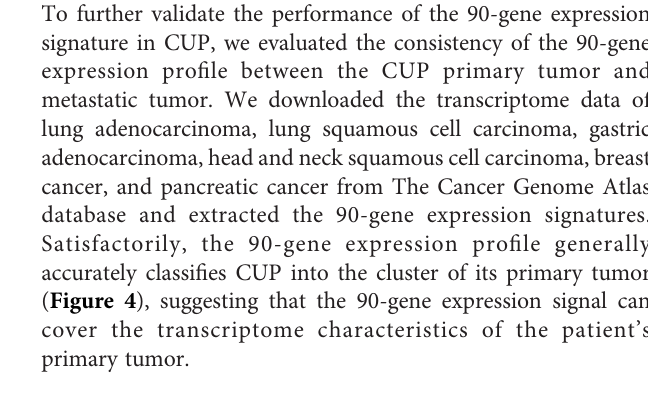
Frontiers in Oncology |